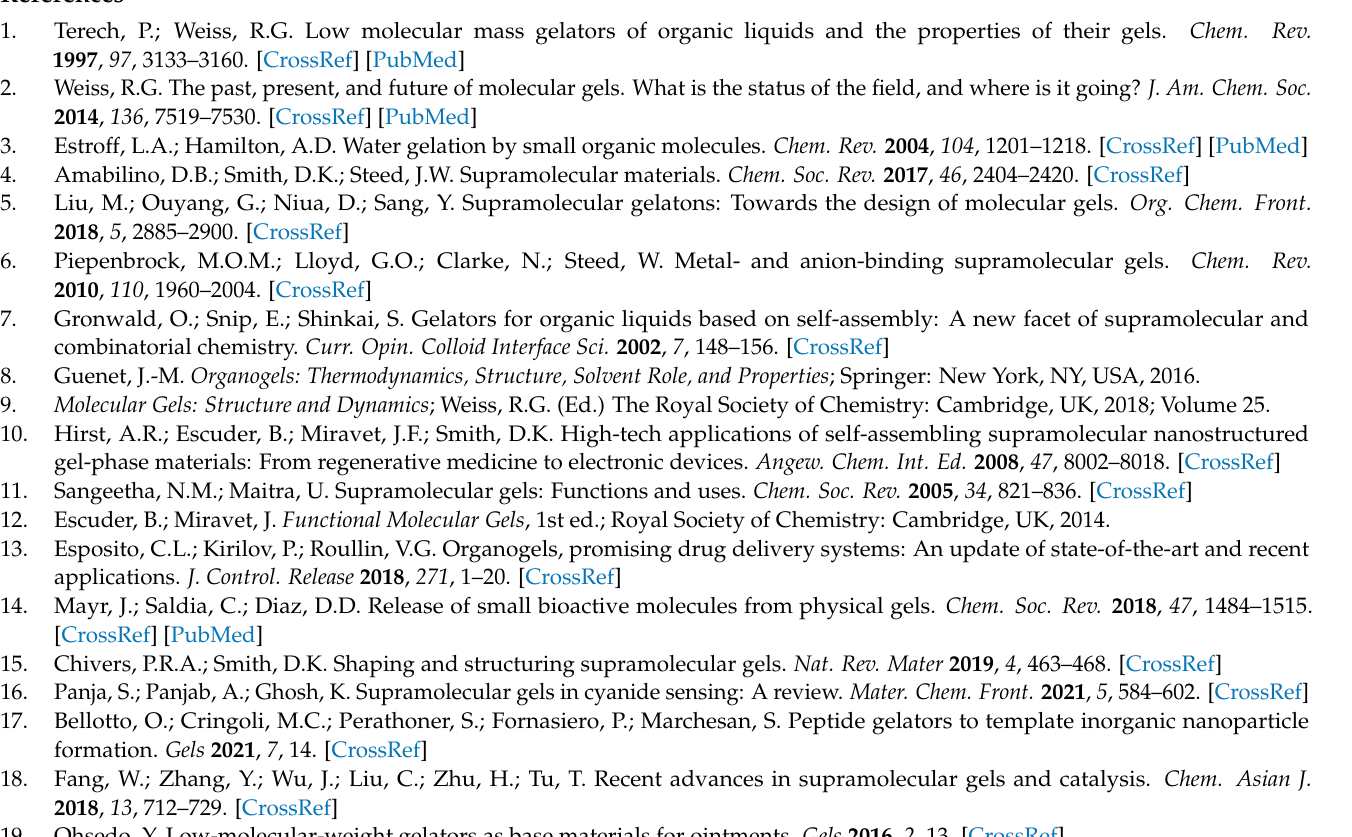
Figure S27: Ball-and-stick computer models of cyclic hexamers from 5-alkylamido ISAs and their approximate maximum diameters; Figure S28: POM images of gels of ISA24 with different solvents; Figure S29: Cryo-SEM images of ISA24 from cyclohexane (2 wt%); Figure S30: FE-SEM images of xerogels of ISA24 from different solvents; Figure S31: 1 H NMR spectra of ISA24 ; Figure S32: Partial ATR-FTIR spectra of ISA24 ; Figure S33: PXRD patterns of ISA24 ; Table S5: Powder X-ray diffraction data of lamello-columno phases of ISA24 from dried gel samples; Table S6: Powder X-ray diffraction data of rectangular columnar (Col r ) phases of ISA24 from dried gel samples; Figure S34: Digital photos of the phase selective gelation by ISA24